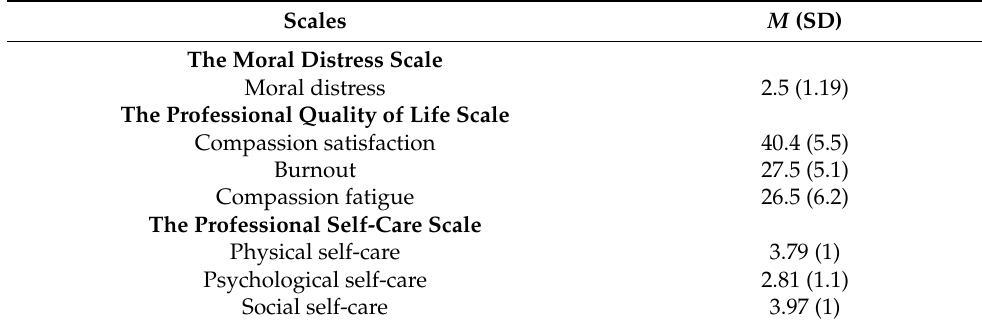
Table 2. Psychological and moral scales used.